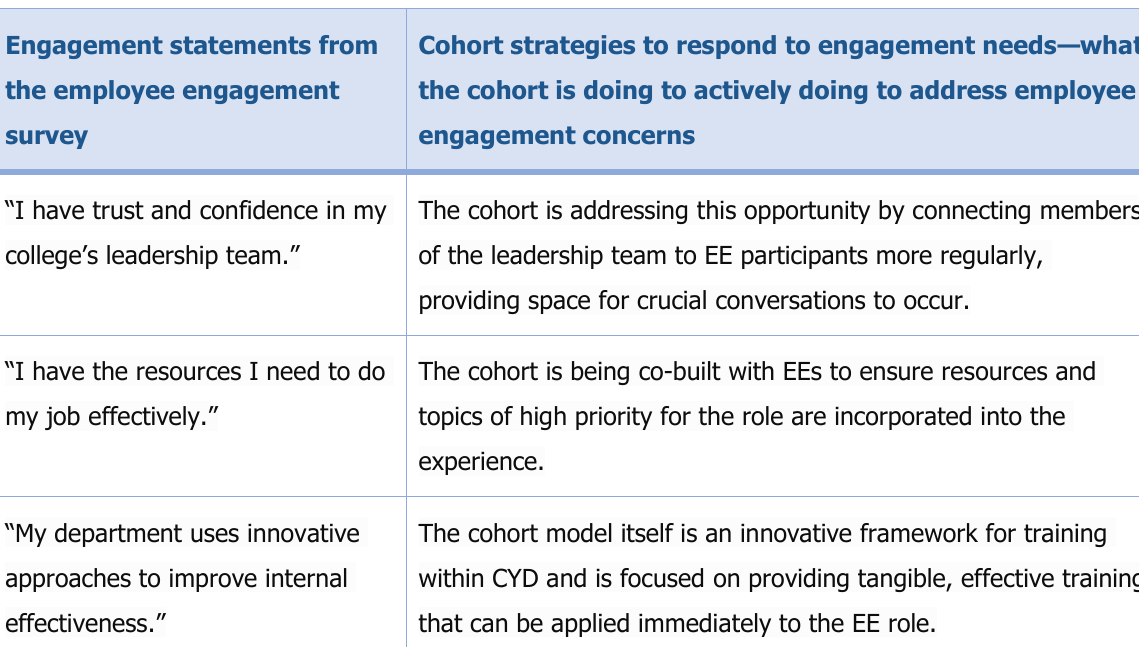
Table 2. Comparison of University of Minnesota Employee Engagement Survey Statements and YDLL Strategies to Address those